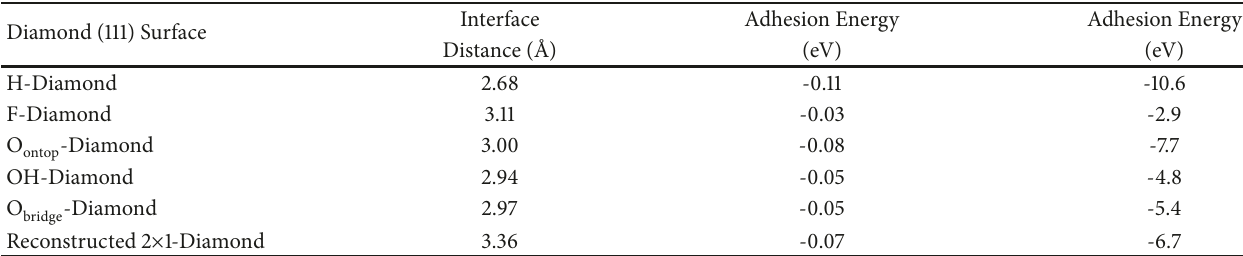
Table 1: Interfacedistances and adhesion energies for a monolayer of graphene adhered to a nonterminated2 × 1-reconstructed diamond (111) surface, or to H-, F-, O -, OH-, and O -terminated diamond (111) surfaces, ontop bridge